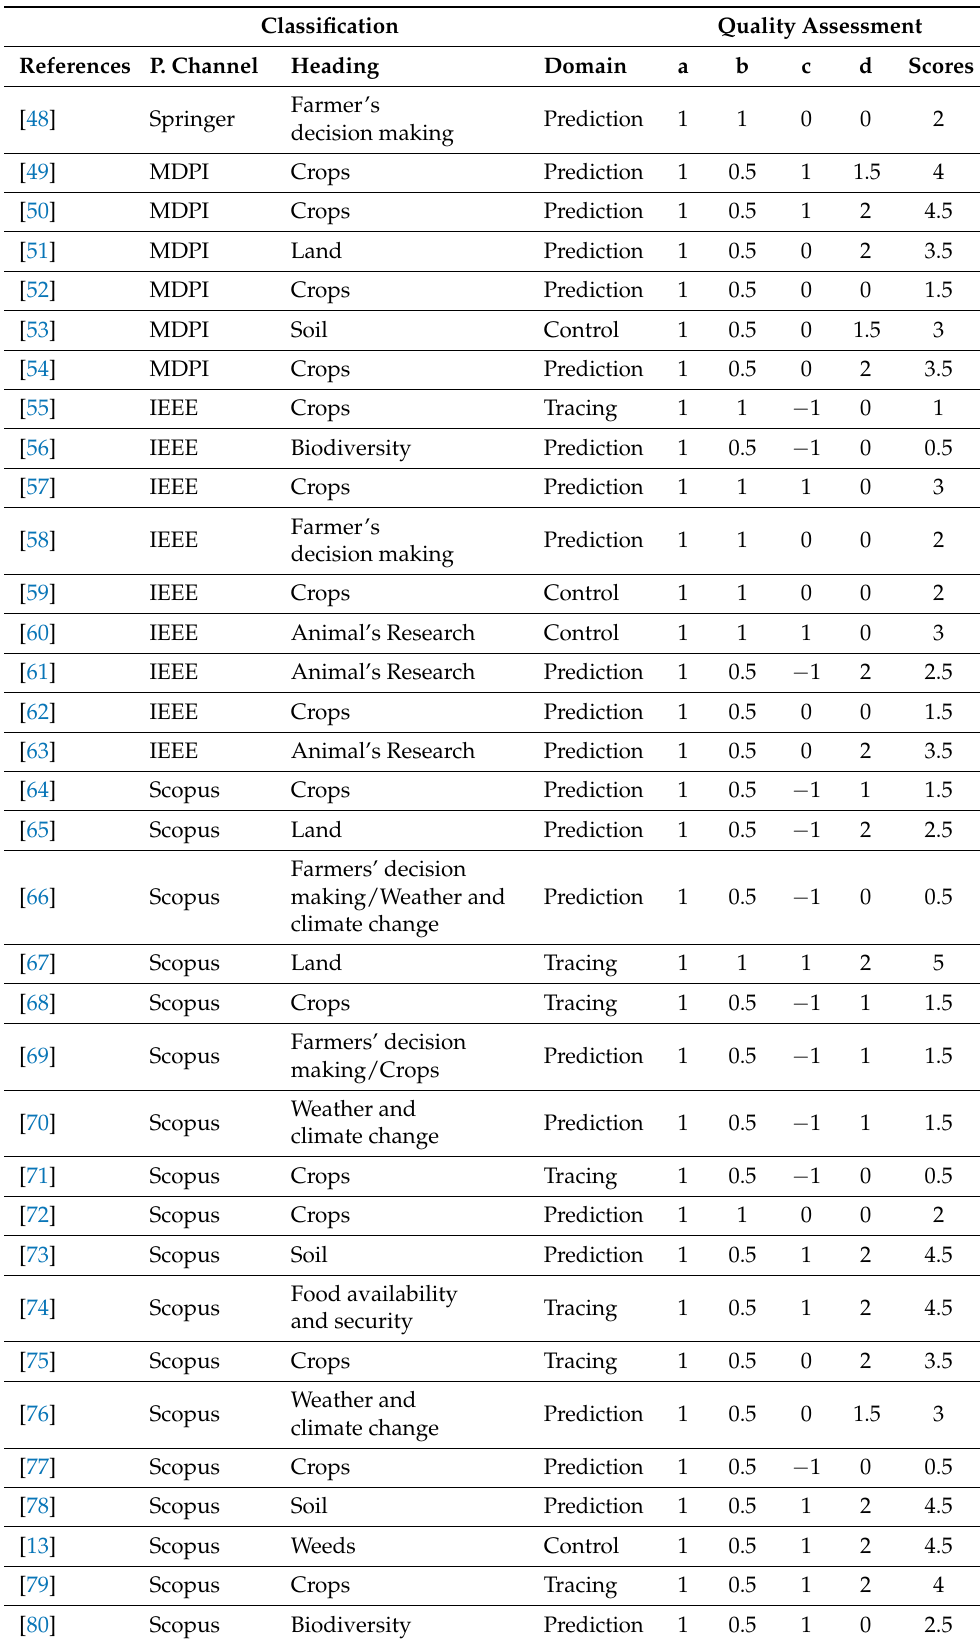
Table 10. Classification and quality assessment